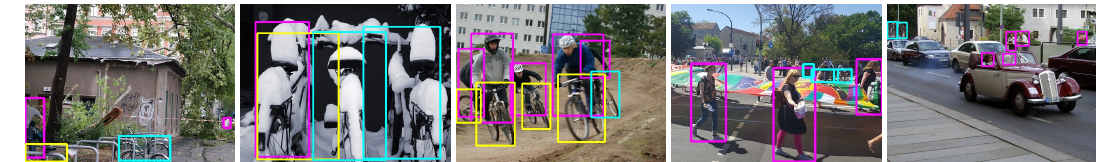
Figure 8. Examples of false classifications into the moving (yellow) and stationary (cyan) categories. Person detections are marked in magenta. From left to right: person coincidentally located next to a stationary bicycle; false person detection; small overlap between person and bicycle detections; undetected person; bicycle moving without a person.